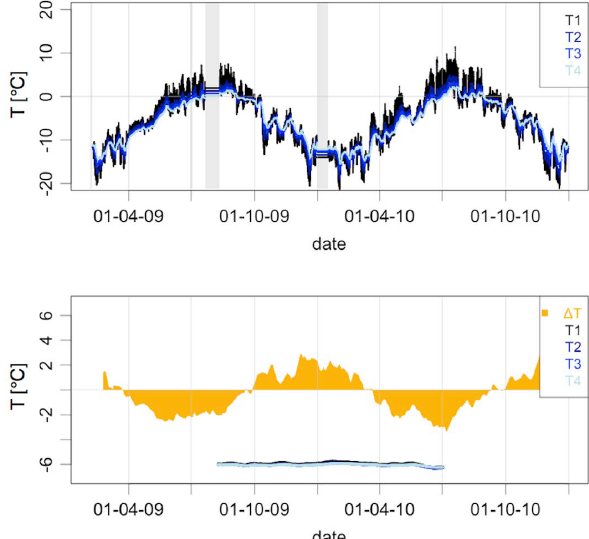
Fig. 10. Time series of rock temperatures at jj05 (TO = 0 ◦ C) mea- sured every 10’ (top) and the temperature difference 1 T = T 4 − T 1 averaged over 30 days (bottom). Additionally the running MATs are ploted in lines similar to Fig. 7 (bottom). Jj05 is a sensor rod at a shadowy